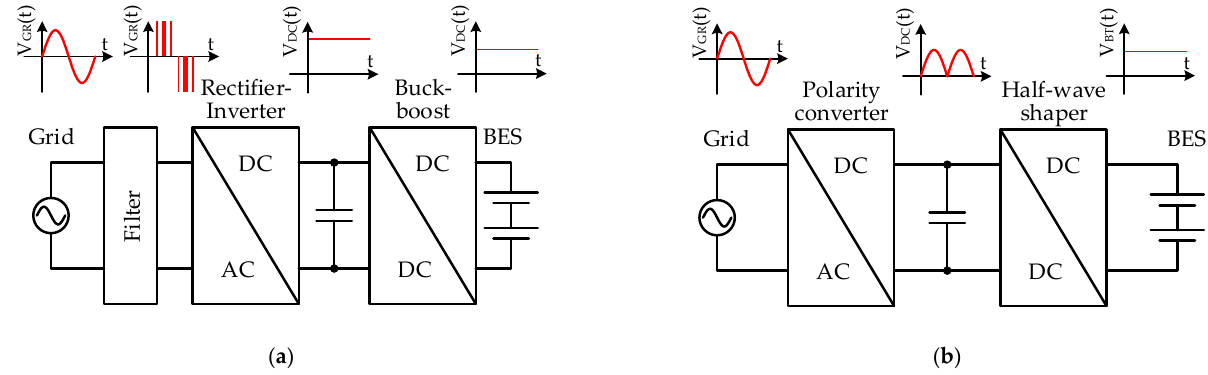
Figure 17. Operation and configuration of BES interface converters with two stages: ( a ) common DC-link, ( b ) unfolding topology.